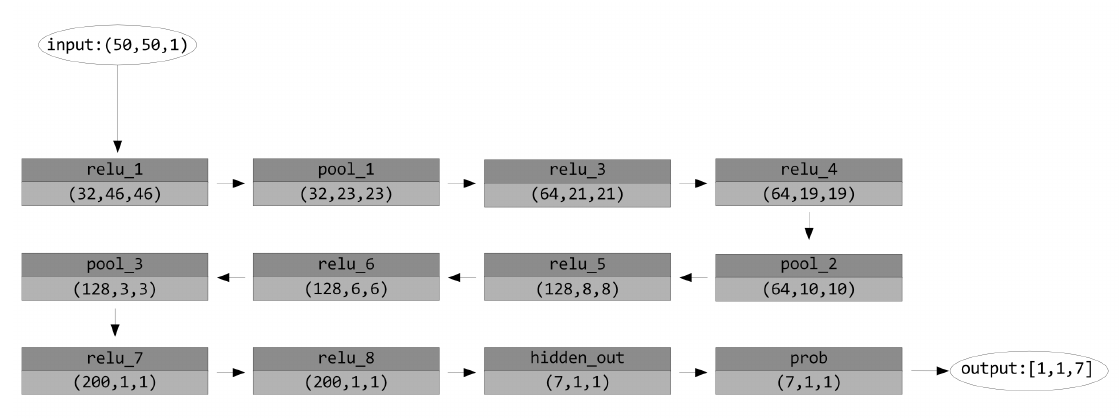
Figure 25. Emotion recognition network.